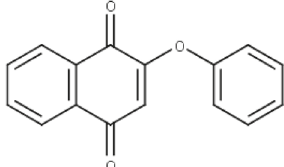
FIGURE 8 - Derivative naphthoquinone that promotes the activity of anti-trypanosomatids.